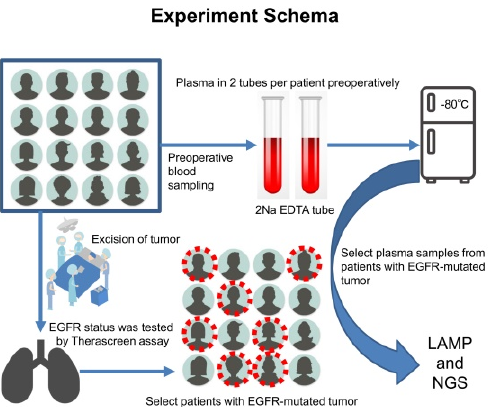
Figure 1. Experimental schema of this study. Plasma samples were obtained from patients with a strong suspicion of primary lung cancer and stored in a freezing chamber preoperatively. After surgery or surgical biopsy, all tissue samples were fixed with 10% buffer formalin at 20–25 ◦ C (24–36 h) to create formalin-fixed, paraffin-embedded tumor blocks. Afterward, hematoxylin– eosin-stained slides were prepared for pathological diagnosis. The Therascreen assay was per- formed to investigate the EGFR status of resected tumor tissues from select cases with EGFR -mutated adenocarcinoma. DNA extraction was performed from plasma samples for both the LAMP and NGS assays.